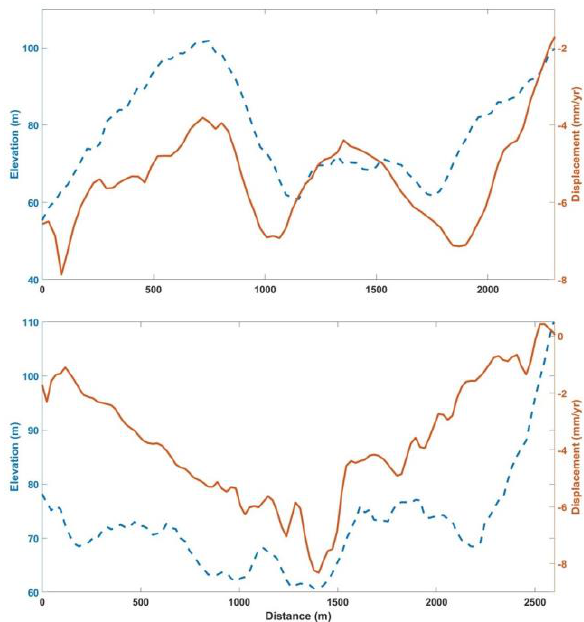
Figure 5. Profile of PSI displacements vs. profile of elevation A mean time series was constructed by using an average of 513 points in time series analysis. The first three years of the time series (91 images), spanning from June 2017 to August 2020, were used to train the displacement model and predict the last two years (60 images) from August 2020 to August 2022. The predicted values were then compared with the monitored time series, and their accuracy was evaluated using the correlation coefficient (R), Root Mean Square Error (RMSE), and RMSE% evaluation indices. The R values for the train and test data were 0.988 and 0.986, respectively (Table 2). The RMSE values were 0.725 mm/year and 0.656 mm/year for the train and test data, respectively. Although the predicted time series exhibited a velocity for the test data, its RMSE% (8.766 mm/year) was approximately half that of the train data (15.749 mm/year). The results indicate a high level of agreement between the monitored and the predicted time series (Figure 6).